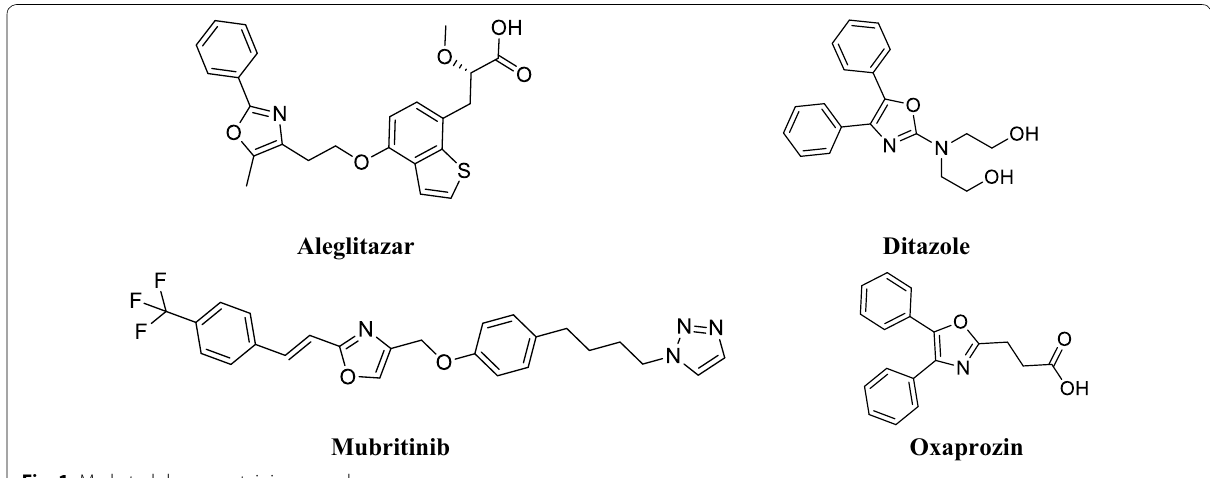
Fig. 1 Marketed drugs containing